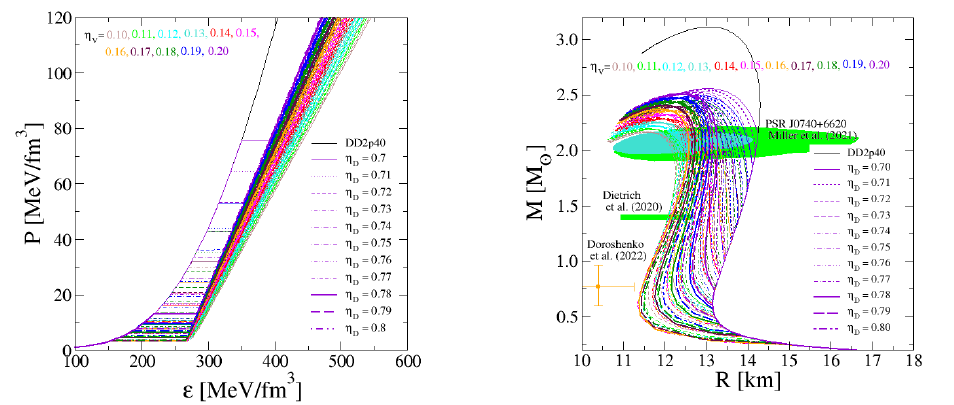
Figure 1. Left panel: family of quark-hadron hybrid EoS obtained within the two-phase approach by a Maxwell construction between the DD2p40 nuclear EOS and the nlNJL quark matter one in its CSS representation. Right panel: mass-radius relation for all hybrid star sequences for which the di ff erent cases of η V are highlighted in colors and each value of η D corresponds to a line style. Observational constraints on masses and radii are shown, for details see